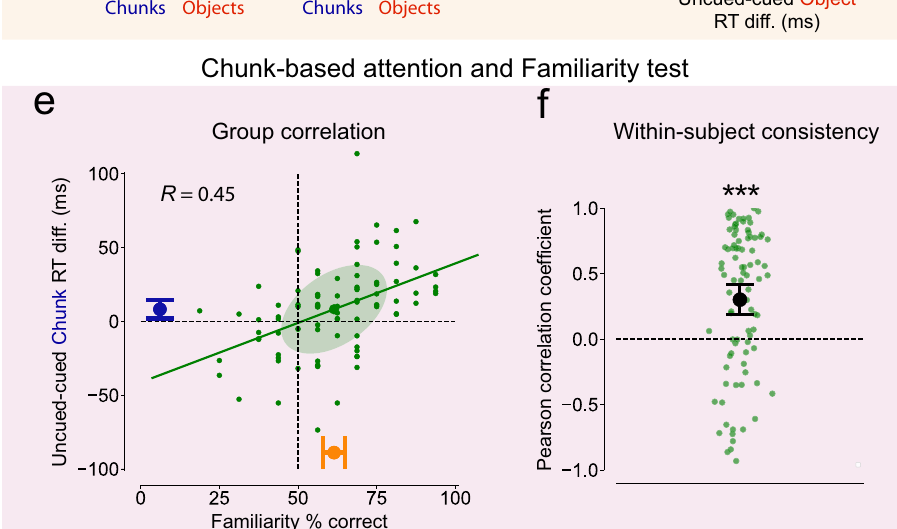
Fig. 4 Chunk- and object-based attentional effects in Experiment 2. a The cue-validity effect for chunks (blue) and objects (red). Dots represent the individual observers ’ validity effect de fi ned as the difference between the median reaction times (right) and mean error rates (left) in the invalid- (uncued) and valid-cue (cued) trials. b Correlation between object-based ( x axis) and chunk-based ( y axis) cue validity with dots representing the corresponding validity effect for each observer. c The chunk-based (CBA, blue) and object-based attention (OBA, red) effects. Dots represent the individual observers ’ OBA/CBA effect de fi ned as the difference between the median reaction times (right) and mean error rates (left) in trials with the target being in an uncued vs. cued chunk/object. d Correlation between object-based ( x axis) and chunk-based ( y axis) attention effects on reaction times with dots representing the corresponding attention effect for each observer. e Correlation between the learned statistical structure and the CBA effect with dots in the scatter plot representing each observer ’ s percent correct values in the Familiarity test ( x axis, mean in orange) and the extent of their CBA effect ( y axis, mean in blue). f Within-subject consistency between learning chunks and the evoked CBA effect. Green dots represent the observer ’ s Pearson correlation coef fi cient between their fraction correct scores and the extent of the CBA effect for each individual chunk. In all plots, error bars denote the 95% con fi dence intervals of the mean, error ellipses cover one standard deviation, and solid lines represent best- fi tting linear regression lines. In the axis labels, RT stands for reaction time and ER stands for error rate. n = 90 in the blocks with statistical chunks ( a , c , e , f in blue and green), and n = 44 in the blocks with geometric objects ( a – d in red and green). Signi fi cant differences from zero in a , c , and f are indicated with ns. p > 0.05, * p < 0.05, ** p < 0.01, *** p < 0.001, two-tailed paired (difference between uncued and cued or invalid and valid chunk/object trials) t -tests. R -values in b , d , and e indicate Pearson correlation coef fi cients. Source data are provided in the Source Data fi le (Fig. 4 worksheet tab in Source